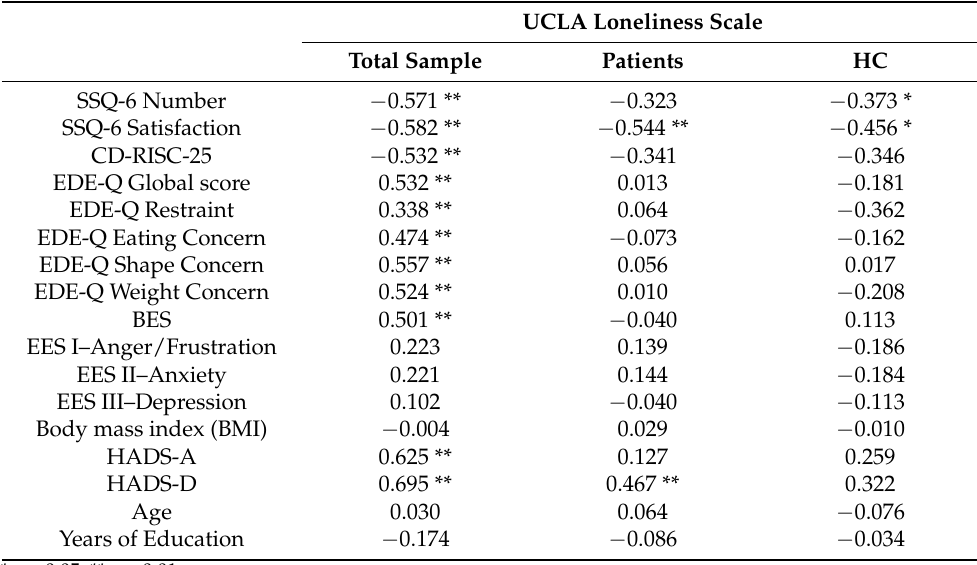
Table 4. Correlations between each continuous variable of the study and loneliness for the total sample and by group.